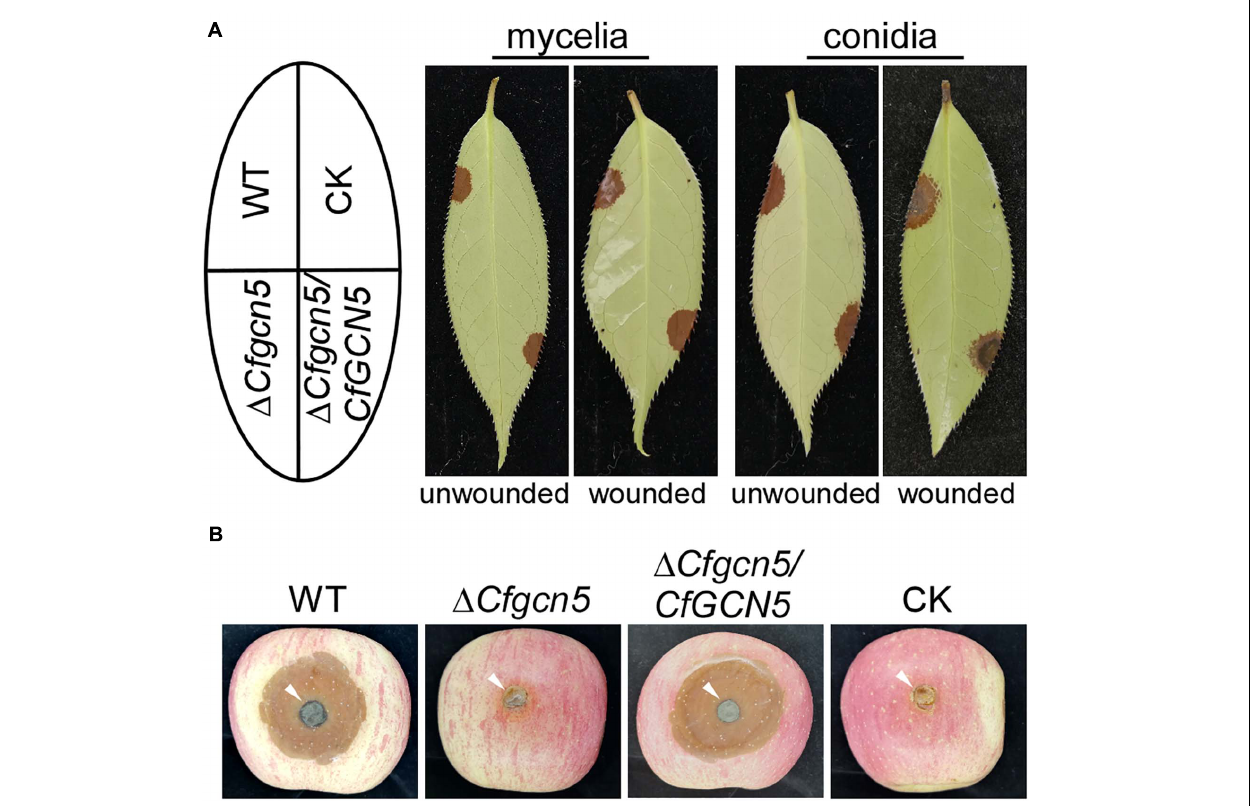
FIGURE 3 | CfGcn5 is essential for pathogenicity. (A) Unwounded and wounded tea-oil tree leaves were inoculated with mycelial plugs or conidial suspensions of WT, (cid:49) Cfgcn5, and (cid:49) Cfgcn5 / CfGCN5 , respectively. Diseased symptoms were photographed at 4 days post inoculation (dpi). (B) Diseased symptoms of wounded apples inoculated with different mycelial plugs at 5 dpi. CK: compared control, the agar plug or ddH 2 O was inoculated onto it.